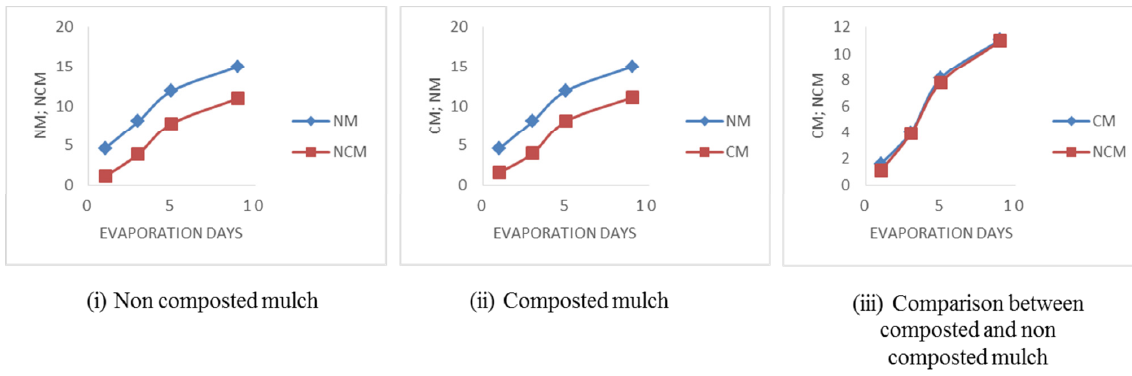
Fig. 1. Effects of Calapogonuim mulch material on soil evaporation NM = No mulch; NCM = non- composted mulch; CM = composted mulch